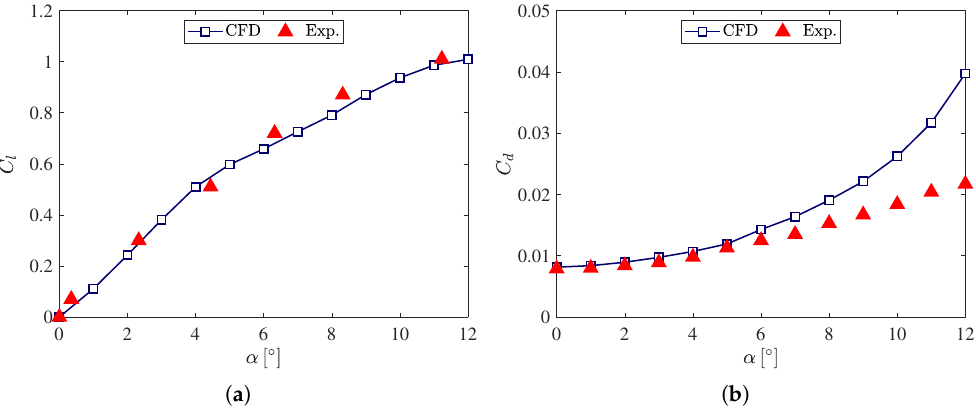
Figure 9. Comparison between lift and drag polar diagrams obtained with the finest grid (using the TSST turbulence model) and the experimental data for NACA 0012 airfoil. ( a ) C l as a function of the incidence; ( b ) C d as a function of the